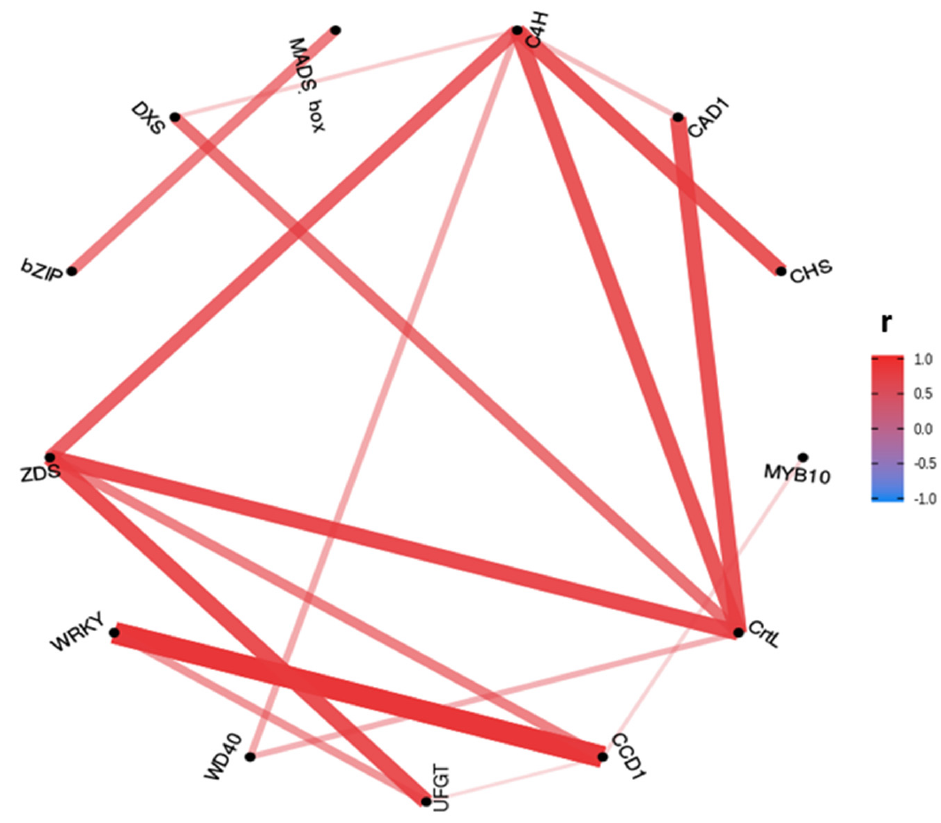
Figure 10. Pearson correlation (r coefficient) network for relative expression by RT-qPCR of genes involved in anthocyanins and carotenoids biosynthesis with correlation values over 0.7. The plotted genes were C4H, CAD1, CHS, MYB10, CrtL, CCD1, UFGT, WD40, WRKY, ZDS, bZIP, DXS and MADS-box.